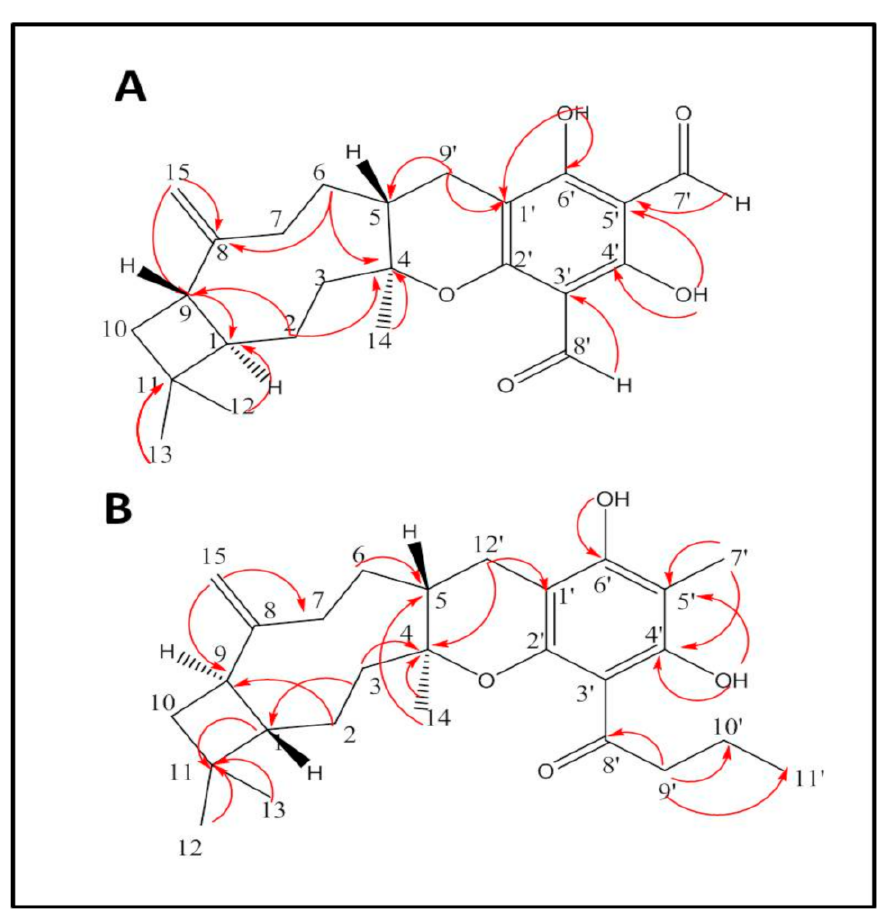
Figure 1. Structure and key HMBC correlations for ( A ): Cattleianal and ( B ): Cattleianone. Compound 2 was isolated as dark yellow oil, soluble in chloroform, [ α ] 25 CHCl 3 ). High resolution ESI-MS in negative mode showed a pseudo molecular ion [M-H] − at m/z 425.26865 calculated for C 27 H 37 O 4 and [2M-H] − ion at m/z 851.54559, (Supplemen- tary Data, Figure S8). UV spectrum of compound 2 (MeOH) showed UV maximum at 294 nm, (Supplementary Data, Figure S9). 1 H-NMR δ ppm (400 MHz, CDCl3): δ H 0.89 (3H, t, J = 6.7 Hz, H-11 (cid:48) ), 0.94 (3H, s, H-12), 1.14 (3H, s, H-14), 1.29 (1H, m, H-2a), 1.47